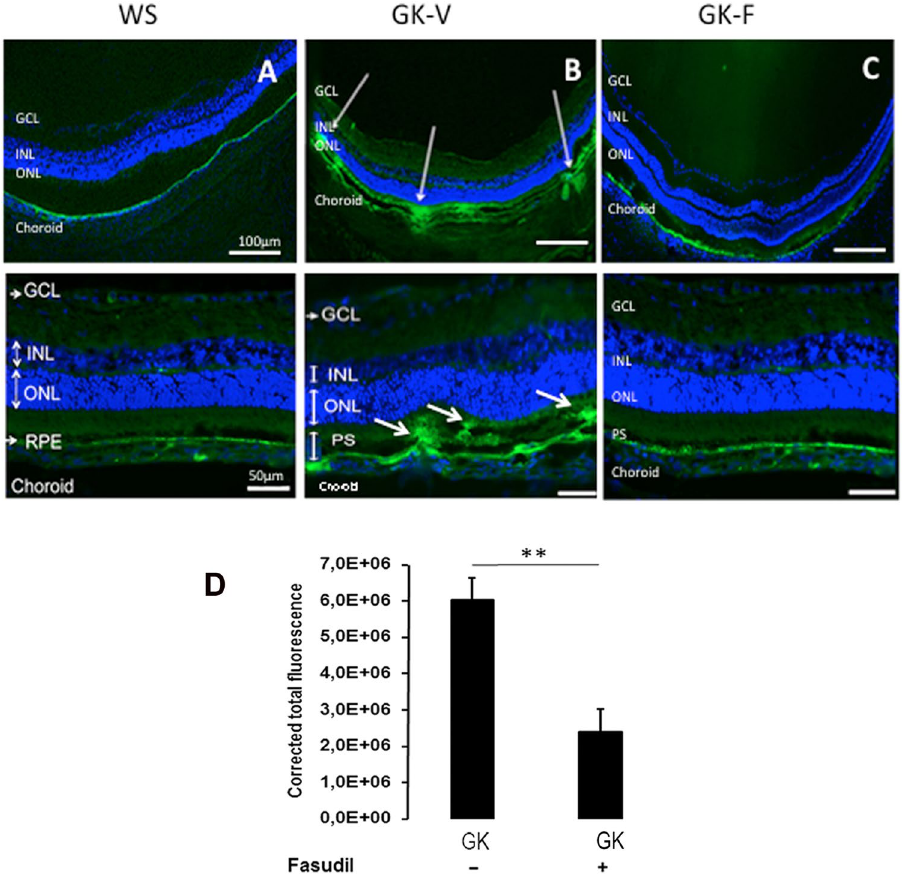
Figure 7. Effect of intravitreal fasudil on GK rat outer retinal barrier permeability. Two hours after an intravenous injection of 150 KDa FITC-Dextran, WS rats and GK rats treated either with vehicle (GK-V) or with fasudil (GK-F) were sacrificed and the eyes sectioned. ( A ) In WS rats, FITC-dextran remains in the choroid vessels and do not cross the RPE. ( B ) In GK rats injected with vehicle (GK-V), similar to control GK rats (not show), FITC-Dextran cross the RPE and diffuses in the outer retina and in photoreceptor segments PS (arrows). ( C ) Fasudil treatment of GK rats (GK-F) restores the RPE barrier as shown by resolution of FITC-dextran leakage in the outer retina. ( D ) Quantification of total retinal leakage was performed by the measurement of neural retina corrected total fluorescence (CTF) (see materials and methods). A significant decrease in CTF consistent with decreased leakage was found for Fasudil treated GK rats (n = 5 per experiment); ** p value < 0, 01; Scale bar = 10 µ m INL = Inner Nuclear Layer; GCL = Ganglion Cell Layer, ONL = Outer retinal Layer, PS = Photoreceptor